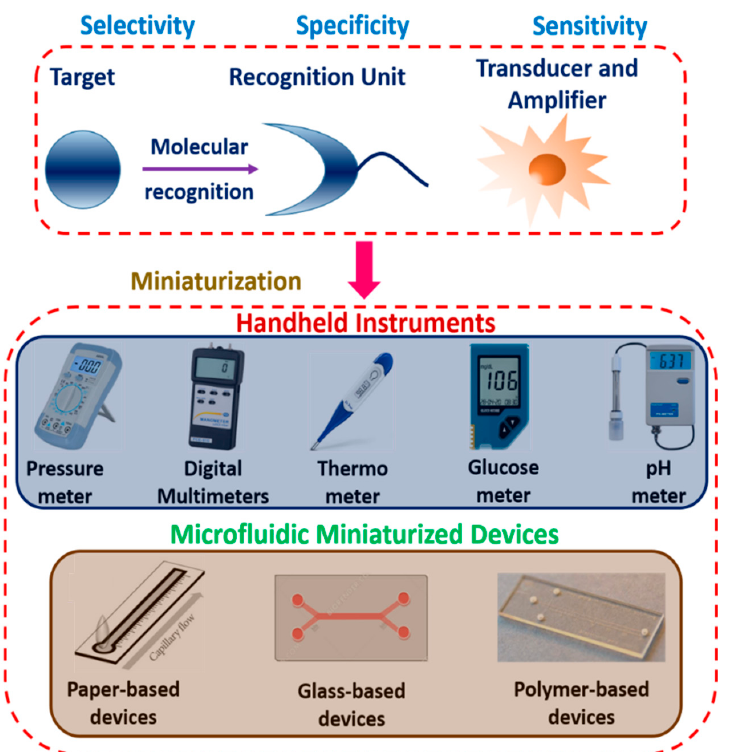
Figure 6. Miniaturized biosensors based on existing handheld devices and microfluidic systems for point-of-care testing (POCT).